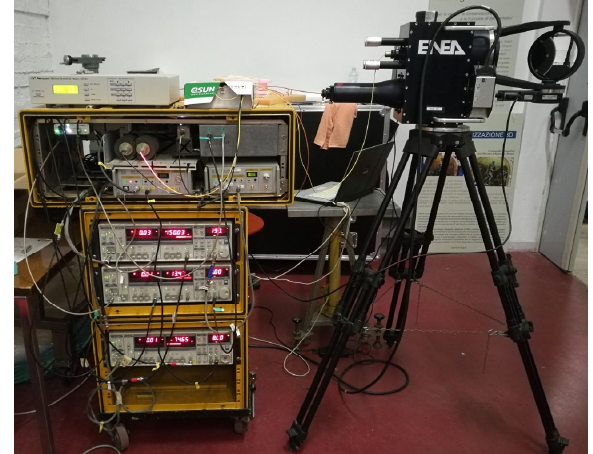
Figure 2. RGB-ITR (Red Green Blue-Imaging Topological Radar) scanner prototype in a laboratory environment, set up with the optical head on a tripod and the electronic components in the tower configuration.